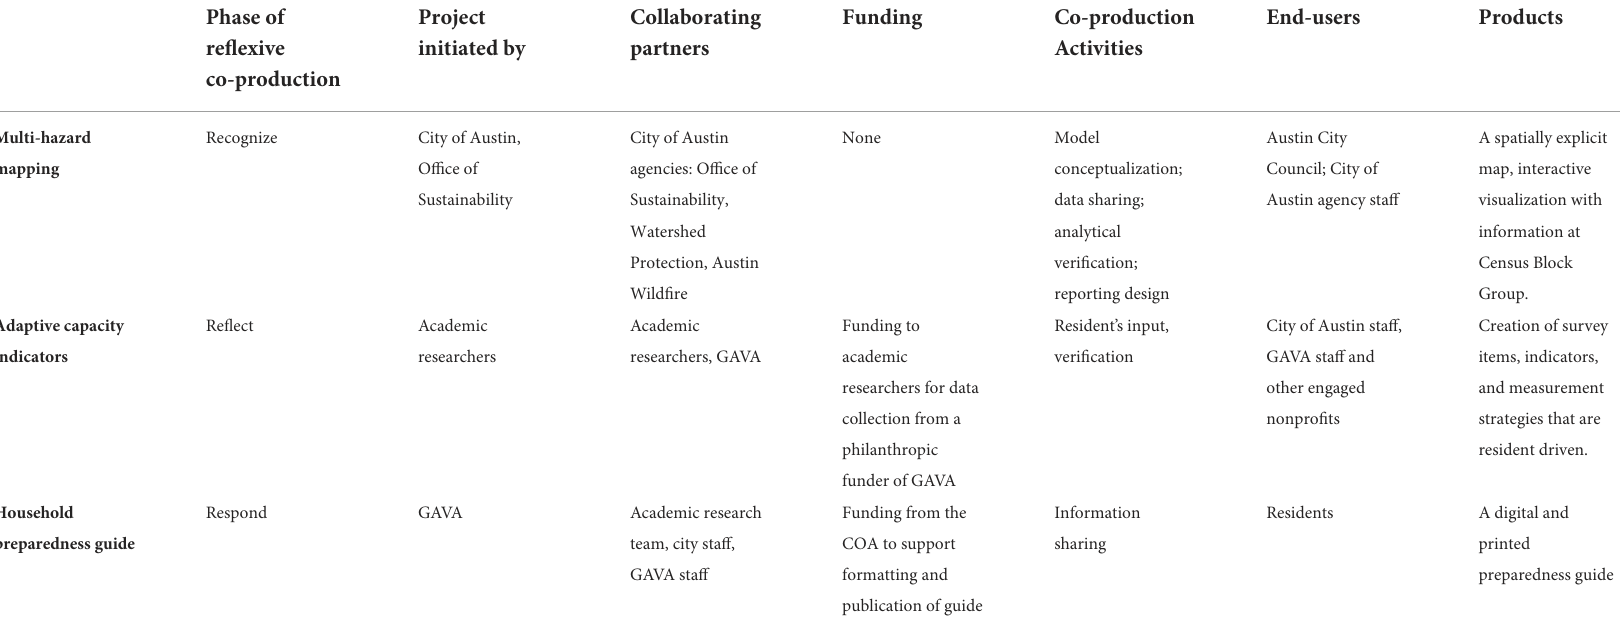
TABLE 1 Summary of the three urban resilience co-production